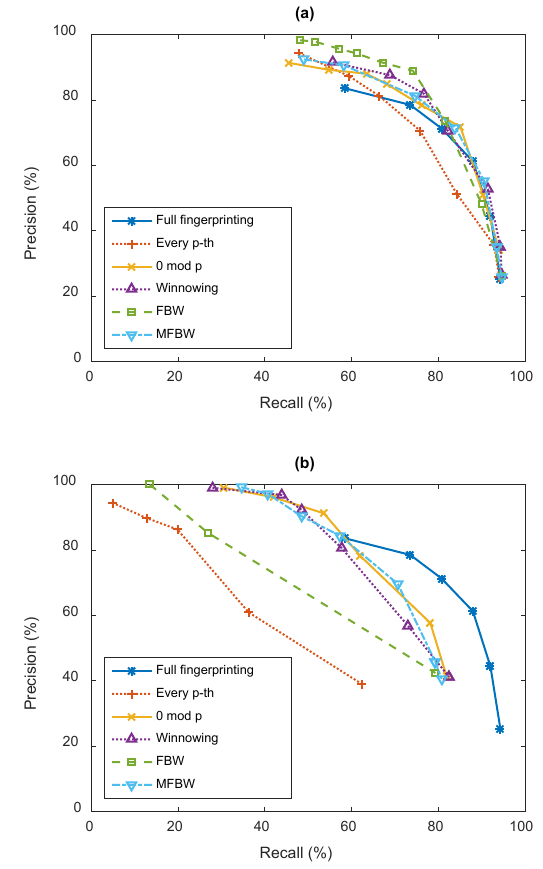
Fig. 2. Precision-recall curves when (a) 50 % and (b) 5 % of fingerprints are selected. Full fingerprinting is shown for reference only since it always selects 100 % of